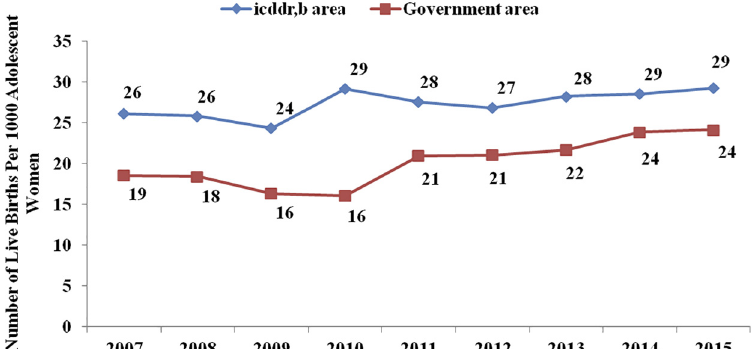
Figure 1. Trends of adolescent fertility rates in the icddr,b service area and government service area,